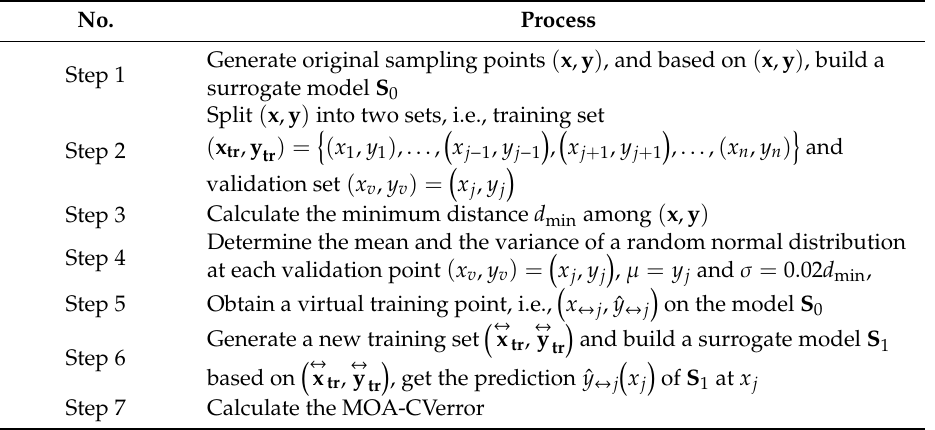
Table 2. Operation Steps of LOO-MCV